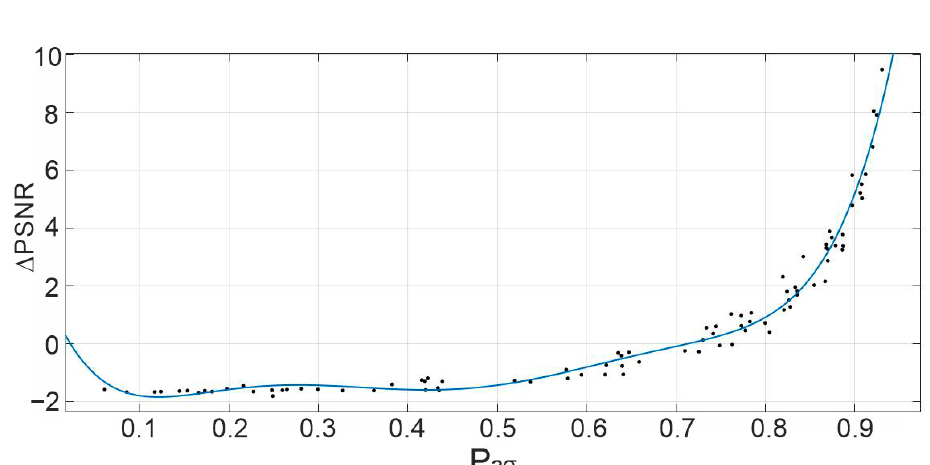
Figure 12. The scatter-plot ∆ PSNR vs. P 2 σ and the fitted curve of the model Fourier 3 (RMSE is about 0.42 and the R 2 and AdjR 2 are about 0.976).